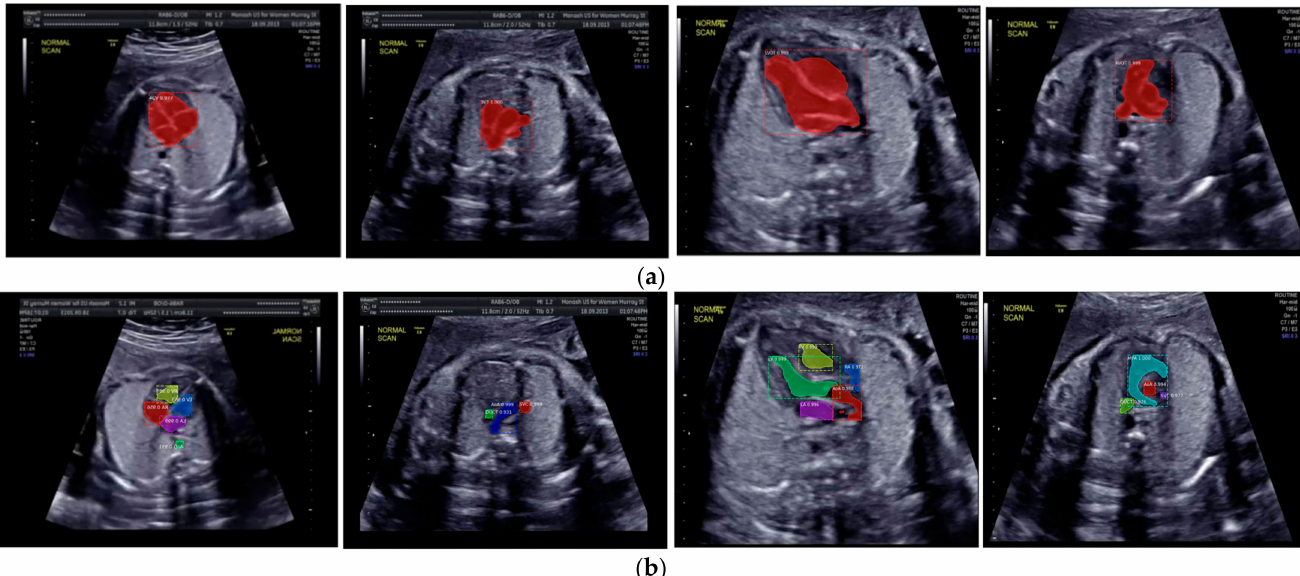
Figure 10. The sample segmentation result of standard view and heart chamber for normal heart anatomy structure: ( a ) red color contour denotes the fetal heart boundary segmentation in each view, from left to right are 4CH, 3VT, LVOT, and RVOT; ( b ) heart chamber segmentation in each view from left to right are 4CH (red: RA, purple: LA, yellow: RV, and blue: LV), 3VT (green: DUCT, blue: AoA, and red: SVC), LVOT (green: LV, red: AoA, blue: RA, and yellow: RV), and RVOT (green: DUCT, cyan: MPA, red: AoA, and purple: